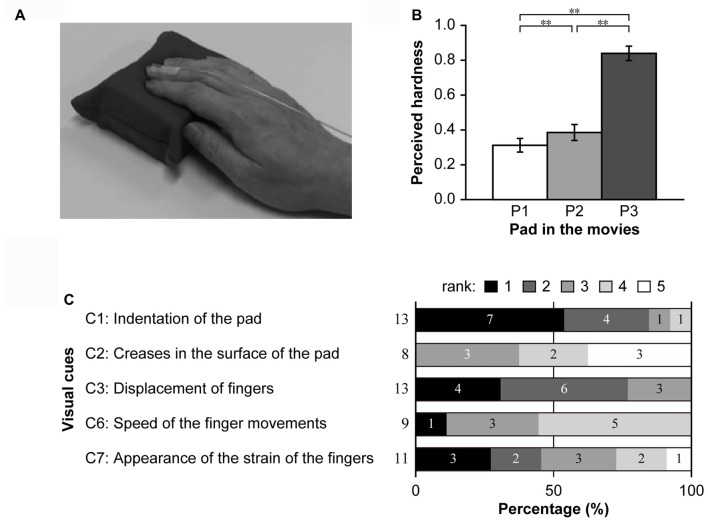
Panel (A) includes a representative screenshot from a movie presented in Experiment 2. Panel (B) shows the results of the hardness estimation test. The means of the estimated hardness values of P1, P2 and P3 over all participants are shown. **p < 0.01. Panel (C) illustrates the visual cues utilized by at least two participants in the hardness estimation test. The percentages of the rank orders for each cue are shown on a scale ranging from black (first) to white (fifth). Numbers at the left side and inside the bar graphs indicate the total number of participants who checked the cue and the number of participants who ranked the cue in the order indicated, respectively.